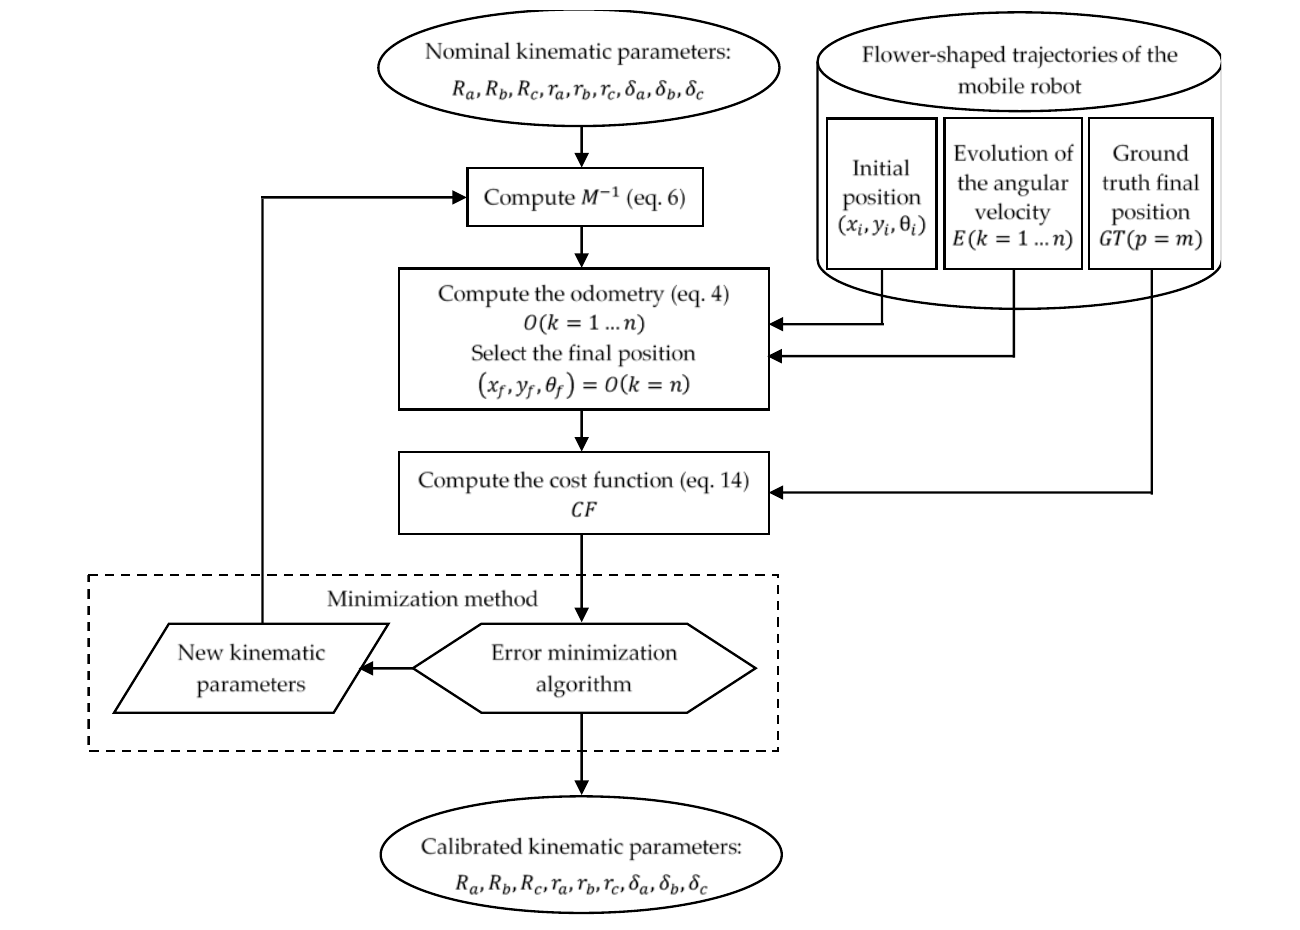
Figure 8. Flowchart of the complete calibration procedure.